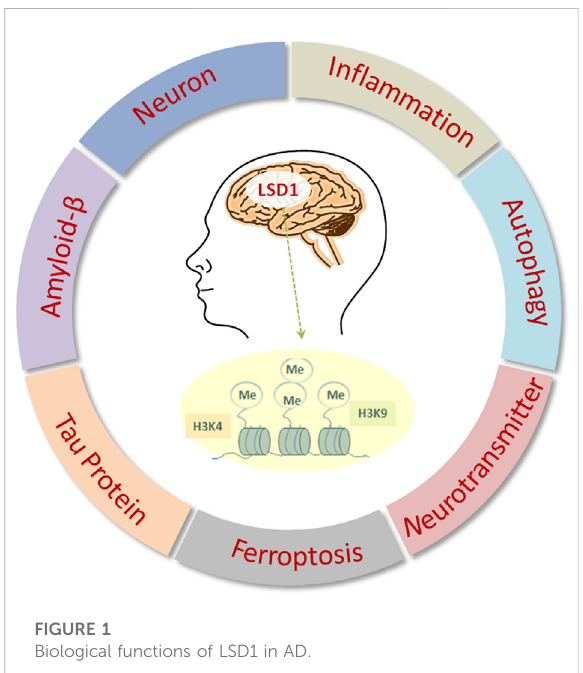
FIGURE 1 Biological functions of LSD1 in